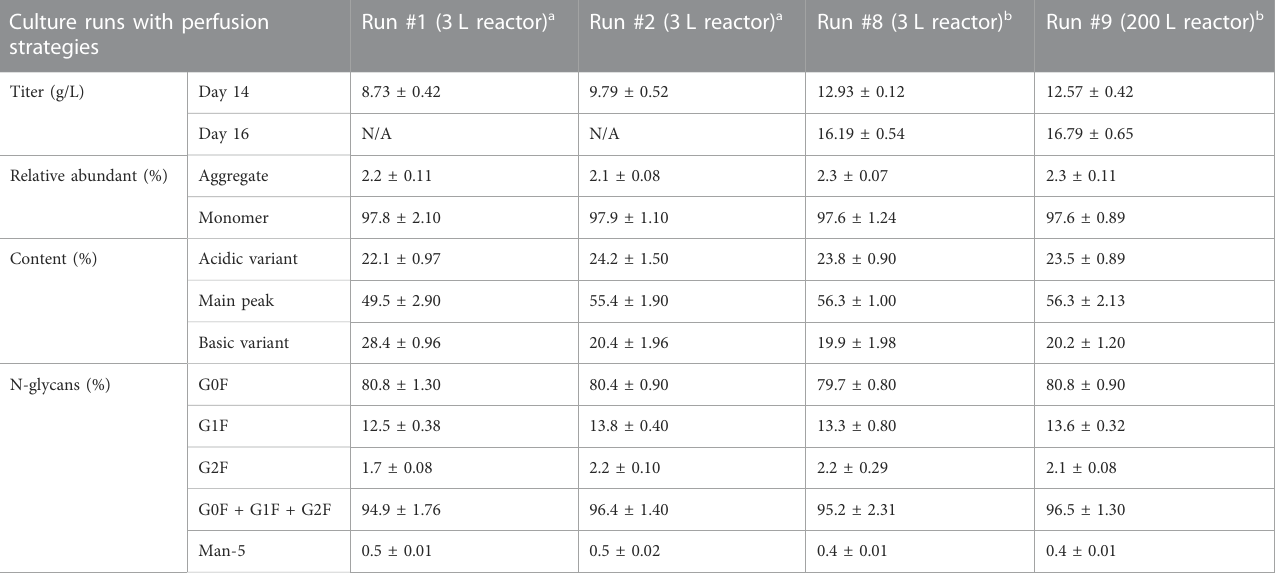
TABLE 3 Protein titers and relative abundant, mAb charge variant content, and percentages of N-glycans under different perfusion strategies. Culture runs with perfusion